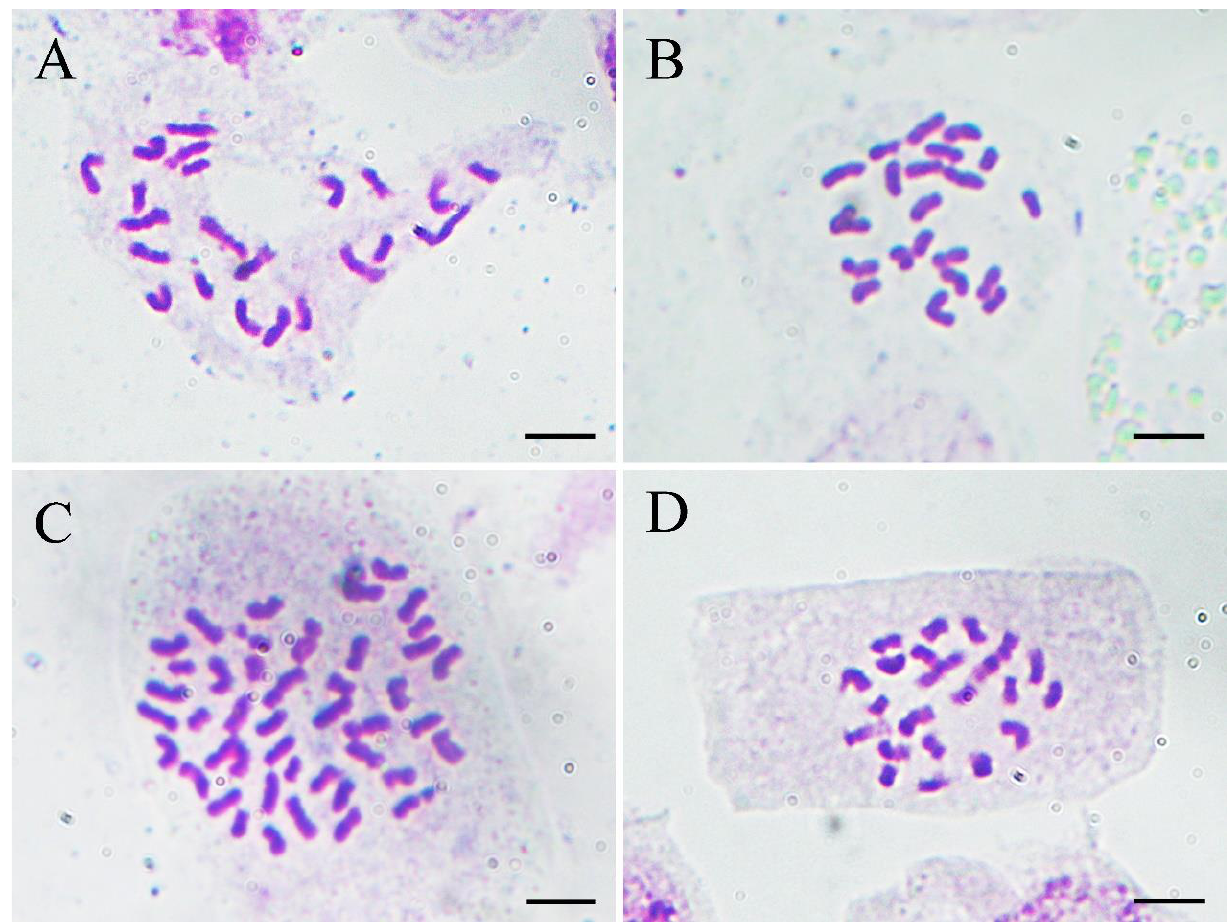
Figure 5. Micrographs (×1000) of somatic chromosomes in the root tips of the normal-type ginger ( A ), the VT1 ( B ), and the VT2 ( C , D ). Scale bars = 10 μm.